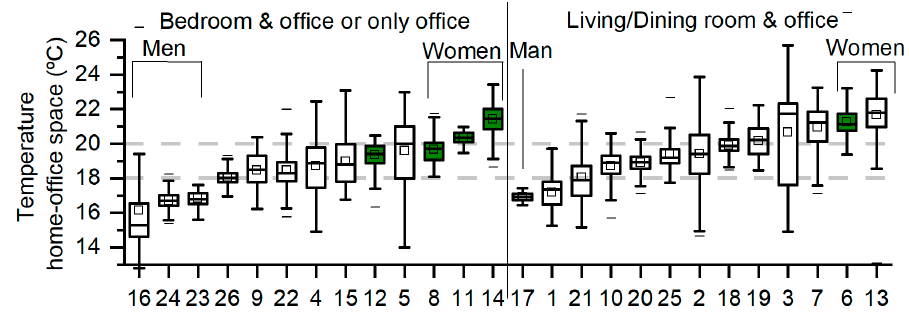
Figure 7. Operative temperatures in home-office space (Filtered). In green, households where families live (couples with children).